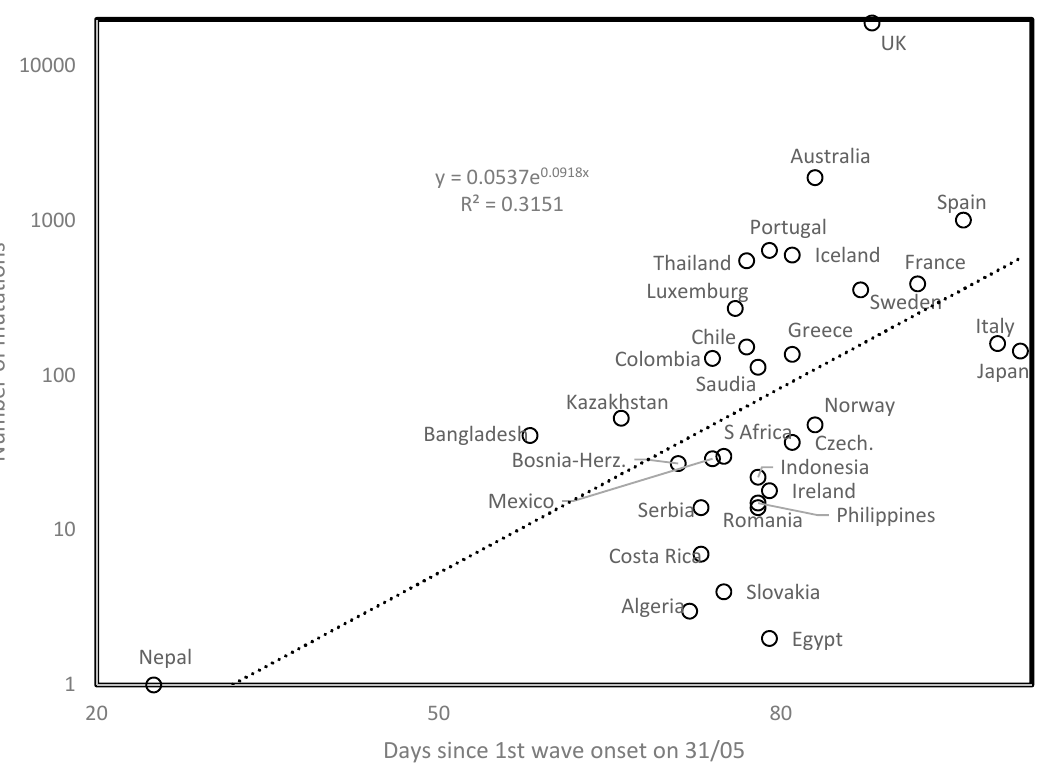
Figure 2. Mutation numbers as a function of days since onset of first wave (determined on 31 May).